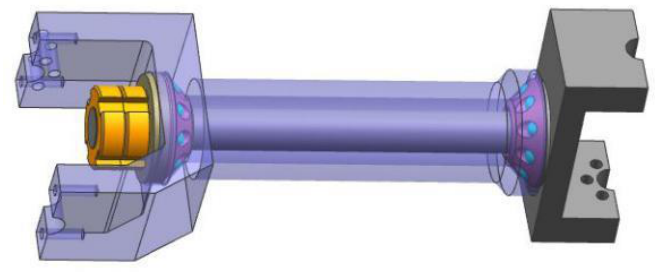
Figure 3. 3D model of the leg.